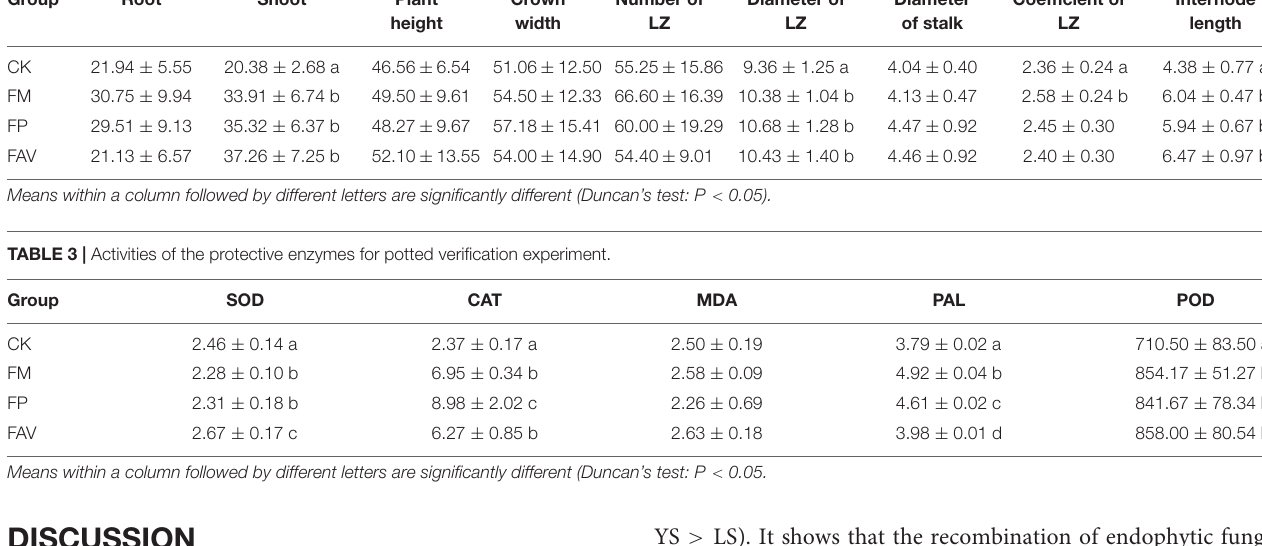
Crown Number of Diameter of Diameter Coefficient of Internode height width LZ LZ of stalk LZ length